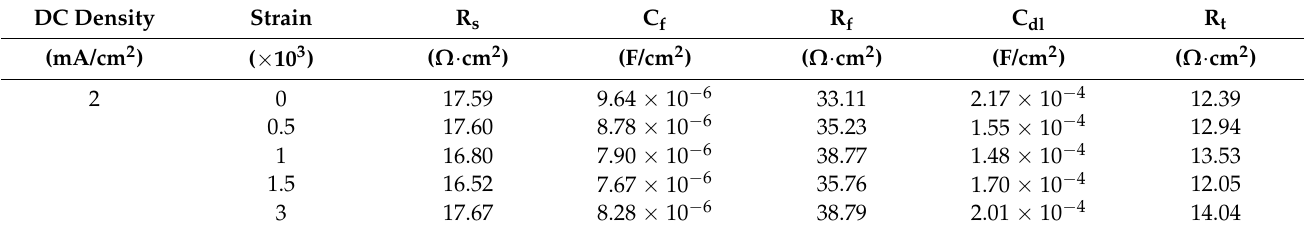
Table 4. Fitted EIS parameters of X80 steel samples after applying various strains and i DC = 2 mA/cm 2 . DC